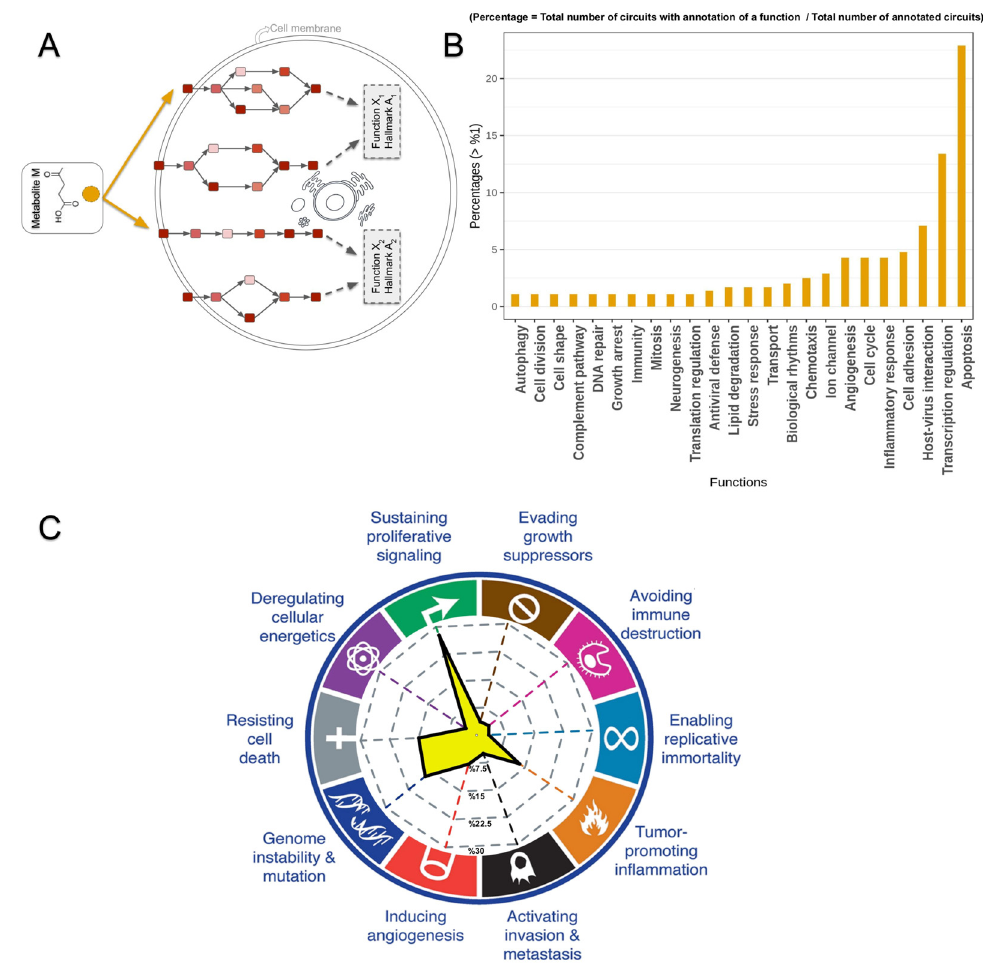
Figure 2. The profile of the annotated metabolites using the Multi-Task Gaussian Processes. ( A ) The illustration shows how cellular functions and hallmarks can be regulated by metabolites via different signaling circuits. A total of 317 metabolites displayed a relevant impact on signaling circuits. ( B ) The distribution of the percentages of the Uniprot functions corresponding to the functional activity of the signaling circuits over which the metabolites have a relevant impact. ( C ) Radar plot with the percentages of cancer hallmarks defined by the functional activity of the corresponding signaling circuits over which the metabolites have a relevant impact.